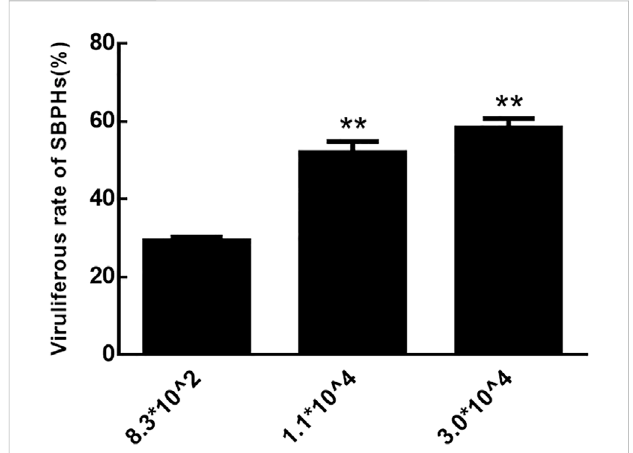
FIGURE 2 Viruliferous rate of SBPHs that fed on RBSDV-infected rice plants with different RBSDV